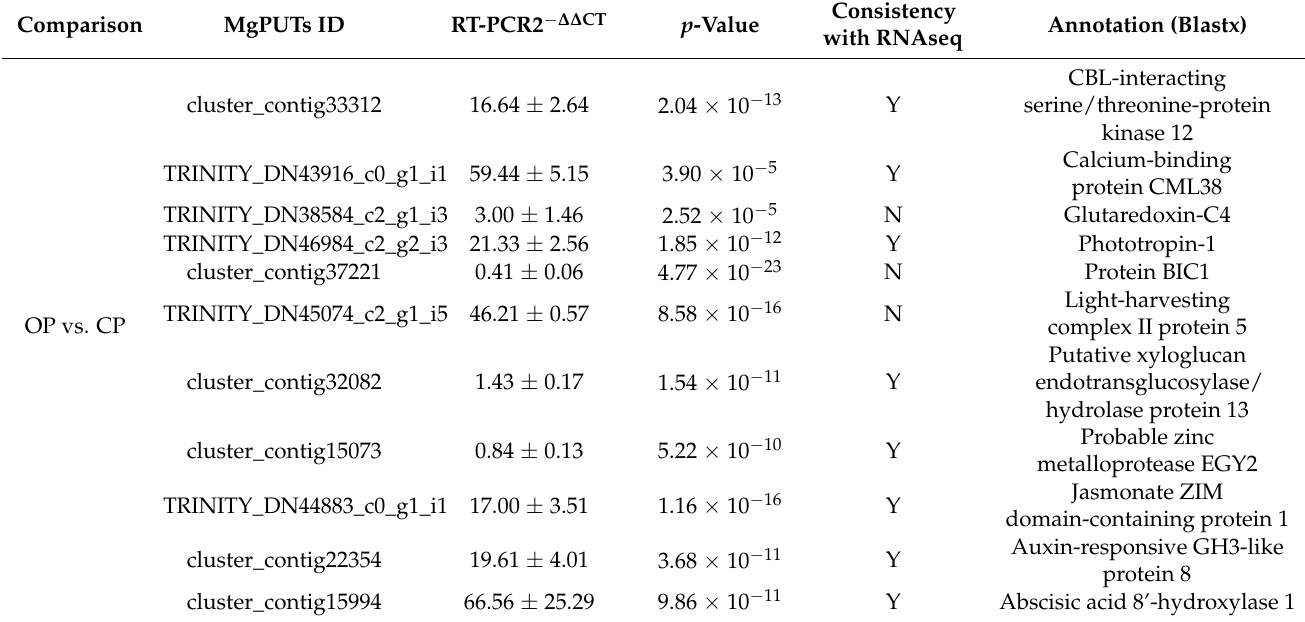
Table 4. The qRT-PCR with the differential expressed